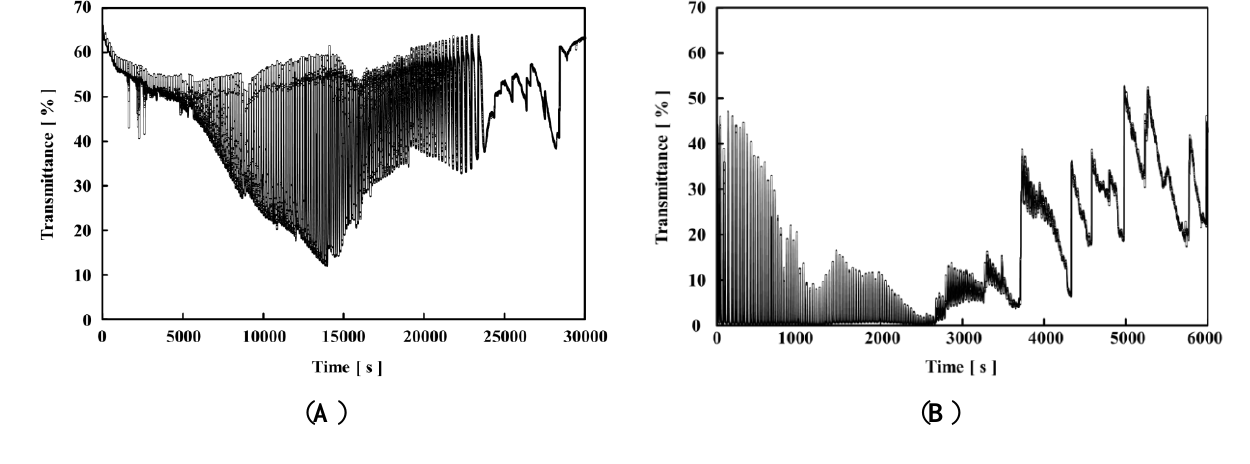
and MA concentrations ([HNO 3